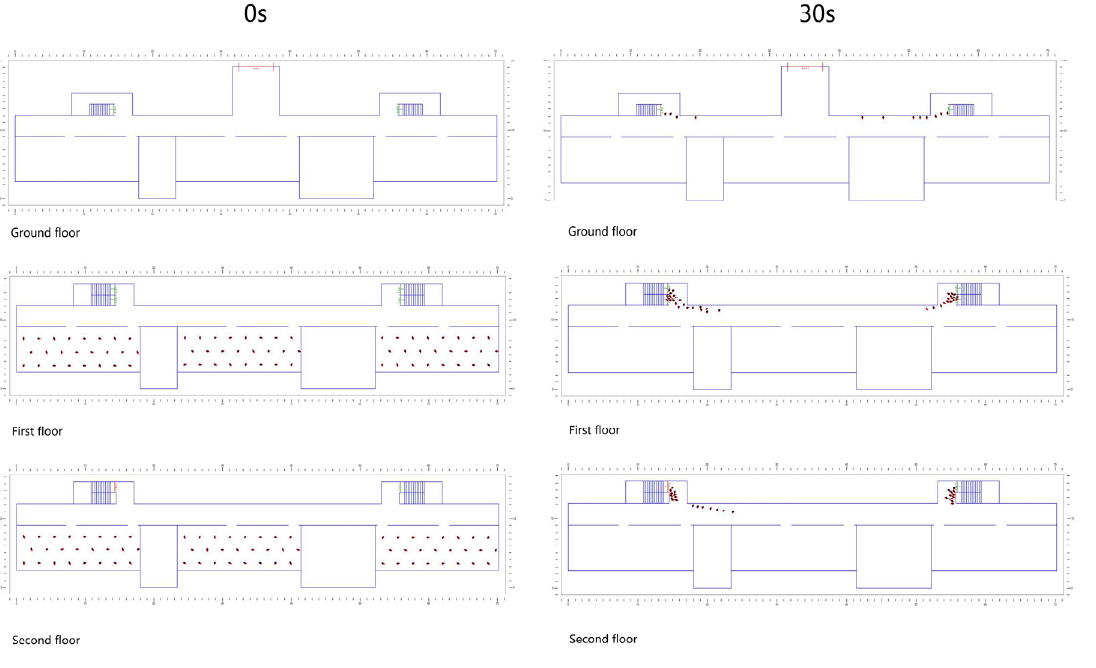
Table 5. Width of stair flight and evacuation time.